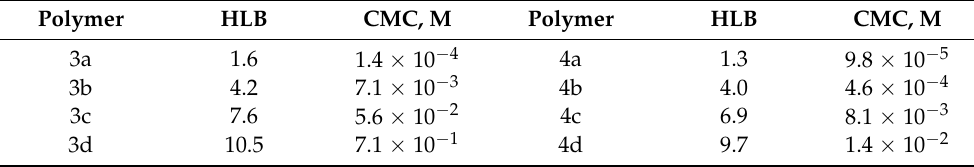
Table 2. The hydrophilic/lipophilic balance (HLB) and CMC values of silatrane-containing polymers.